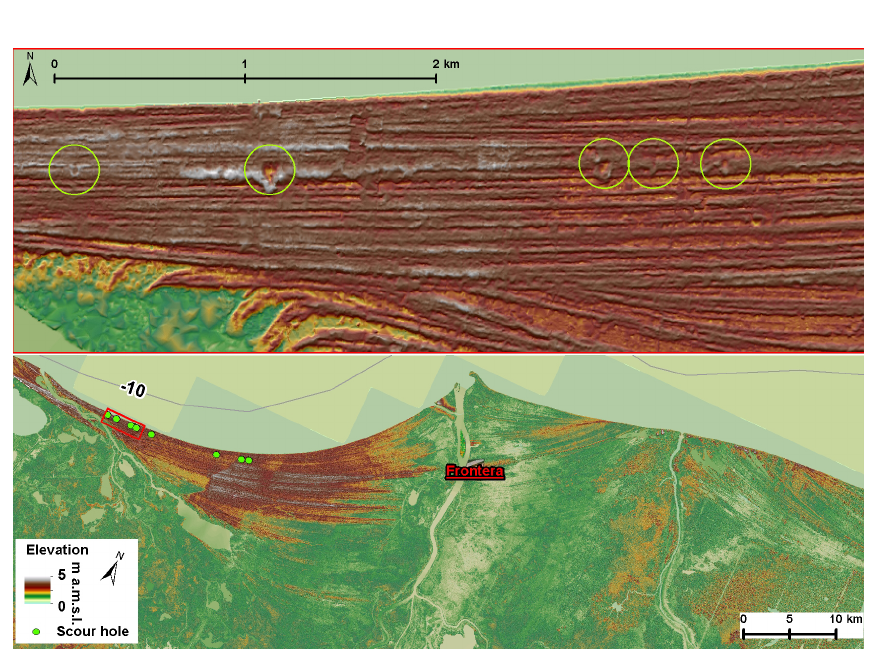
Figure B1. Scour holes along a beach ridge formed around